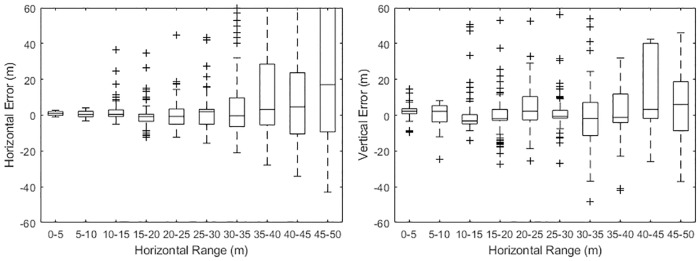
Measured range and depth errors as a function of horizontal distance.